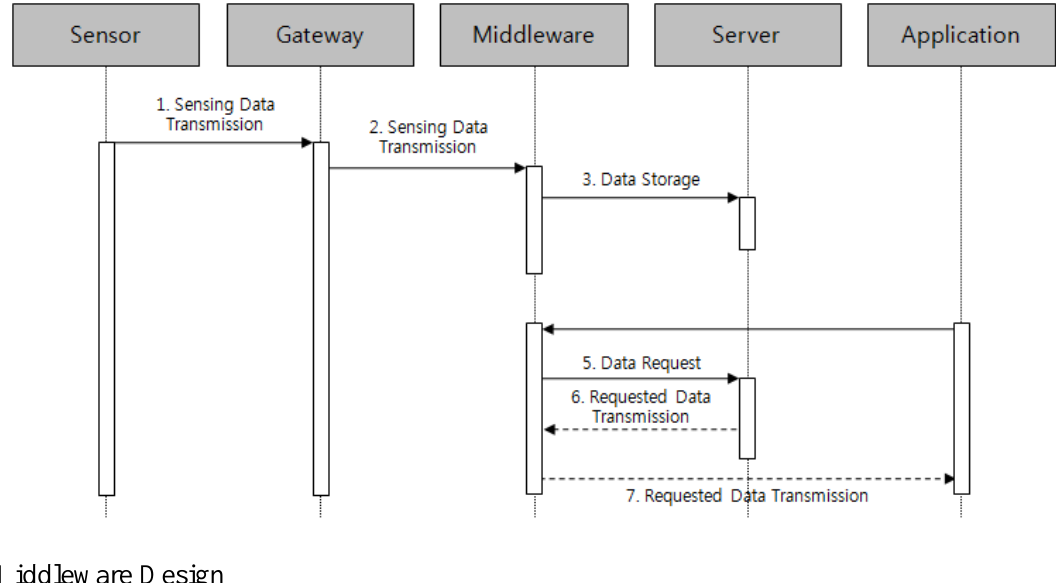
Figure 9. Sequence diagram of the greenhouse information search service.